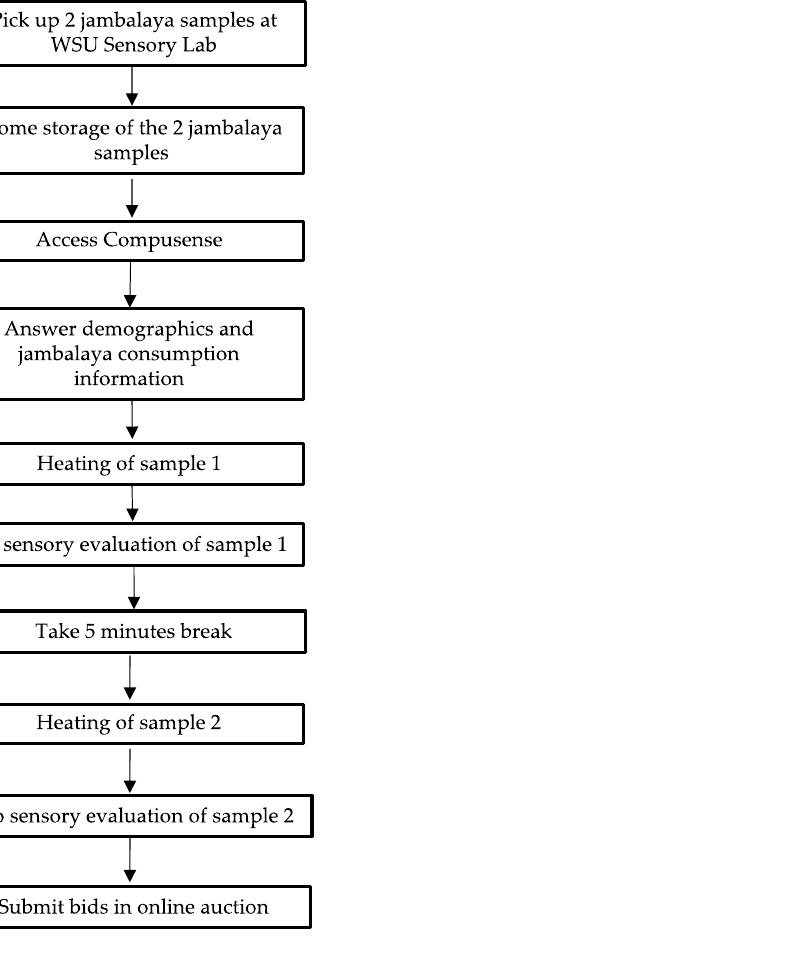
Figure 1. Instructions provided to the panelists in the home-use test evaluation of